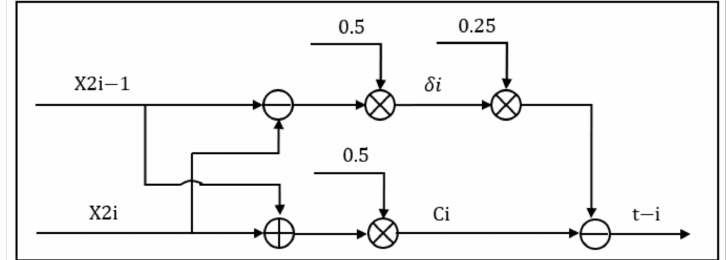
Figure 13. Solving center position c i , pulse width δ i , and result output